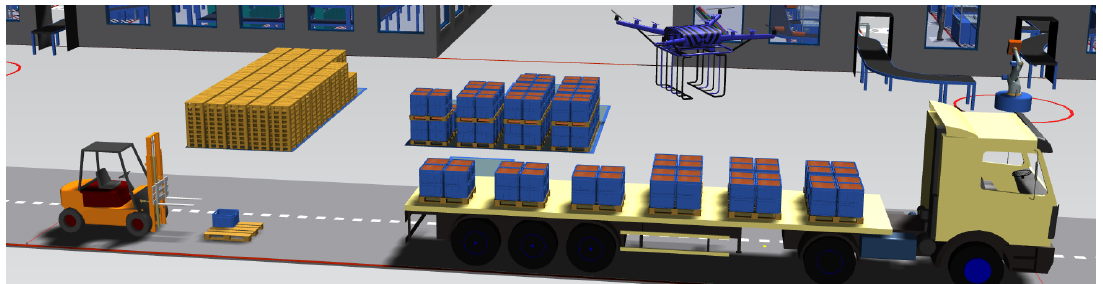
Figure 6. MultimodalLoCo case study. Inspired by Bemthuis et al. [20] and modified in Tecnomatix Plant Simulation